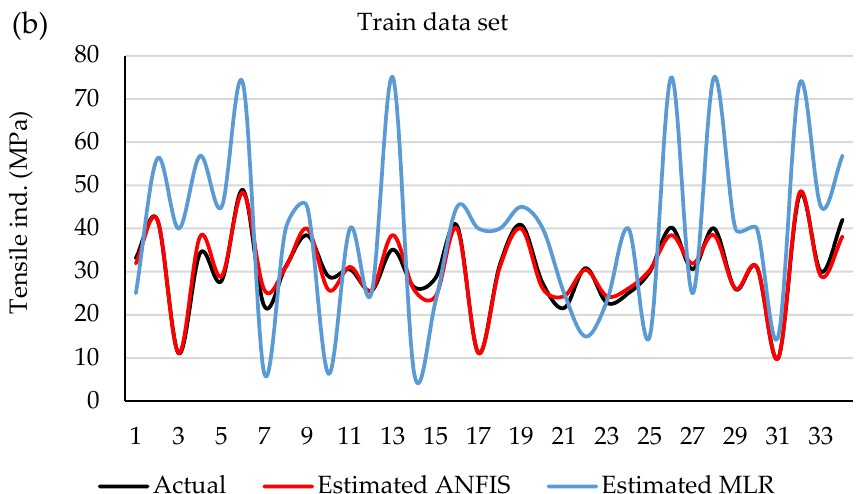
Figure 6. Comparison of experimental and predicted values of test ( a ) and train ( b ) data sets by the ANFIS and MLR models for each experimental run.